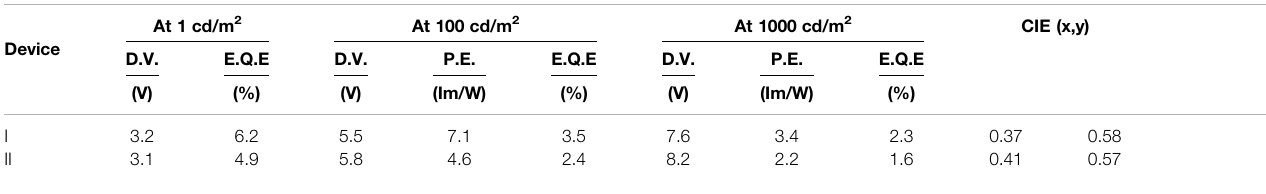
TABLE 1 | Characteristics of OLED devices I (1 wt%) and II (5 wt%). At 1 cd/m Device